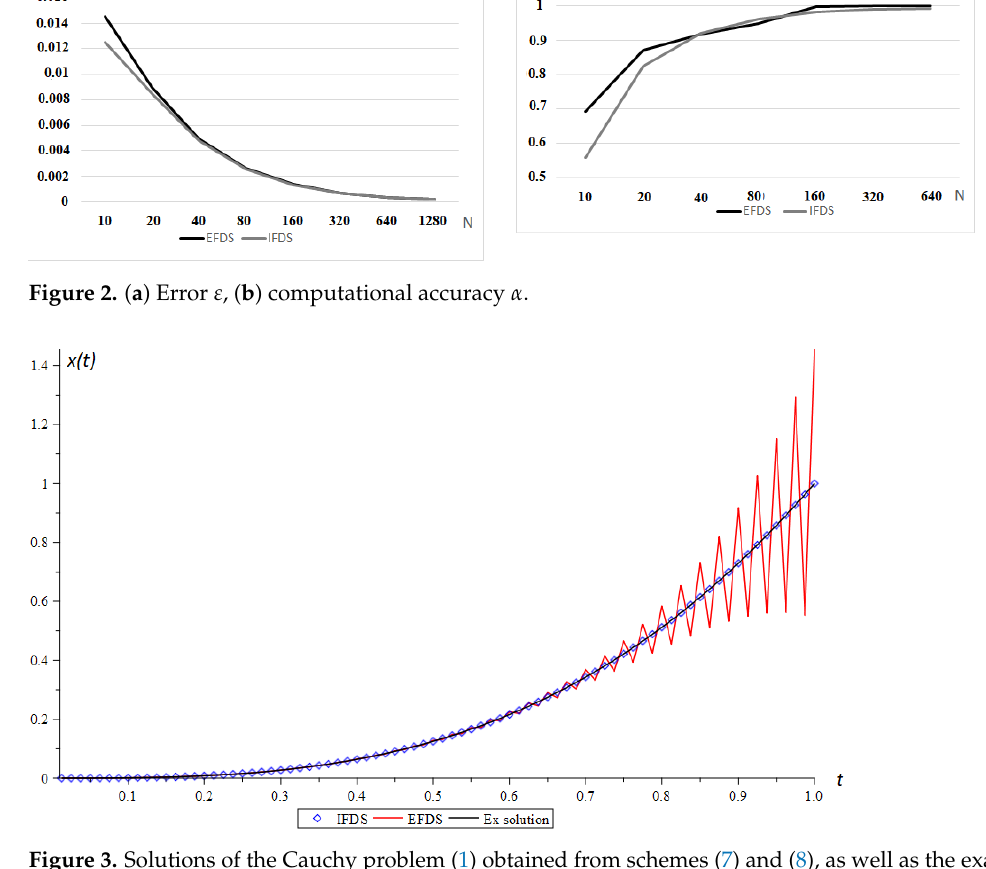
Figure 3. Solutions of the Cauchy problem (1) obtained from schemes (7) and (8), as well as the exact solution (12). For the EFDS (7), the conditions of Theorems 1 and 2 are